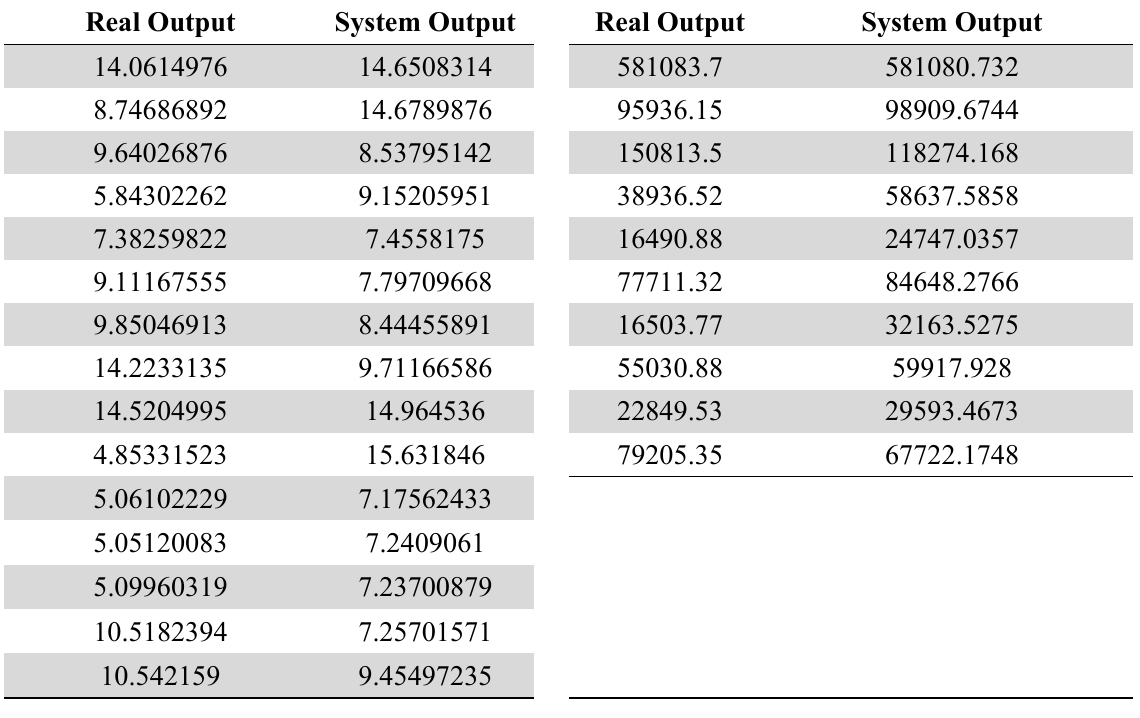
Comparing the Outputs of Liquidity Risk Eval- uation Model with Real